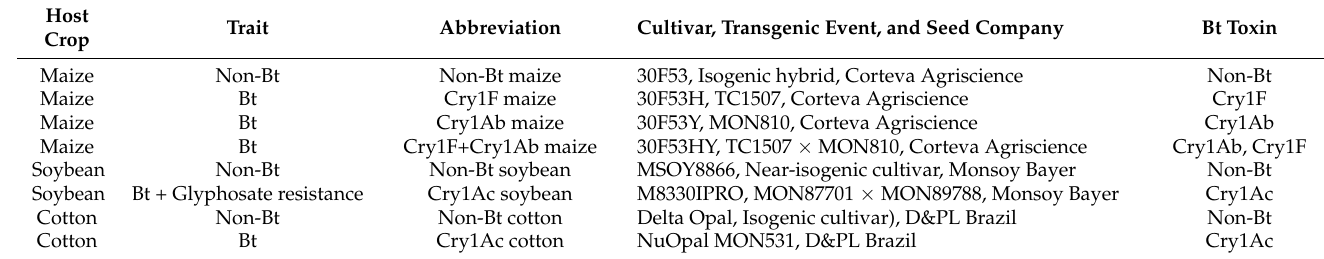
Table 1. Non-Bt and Bt crop cultivars used in the